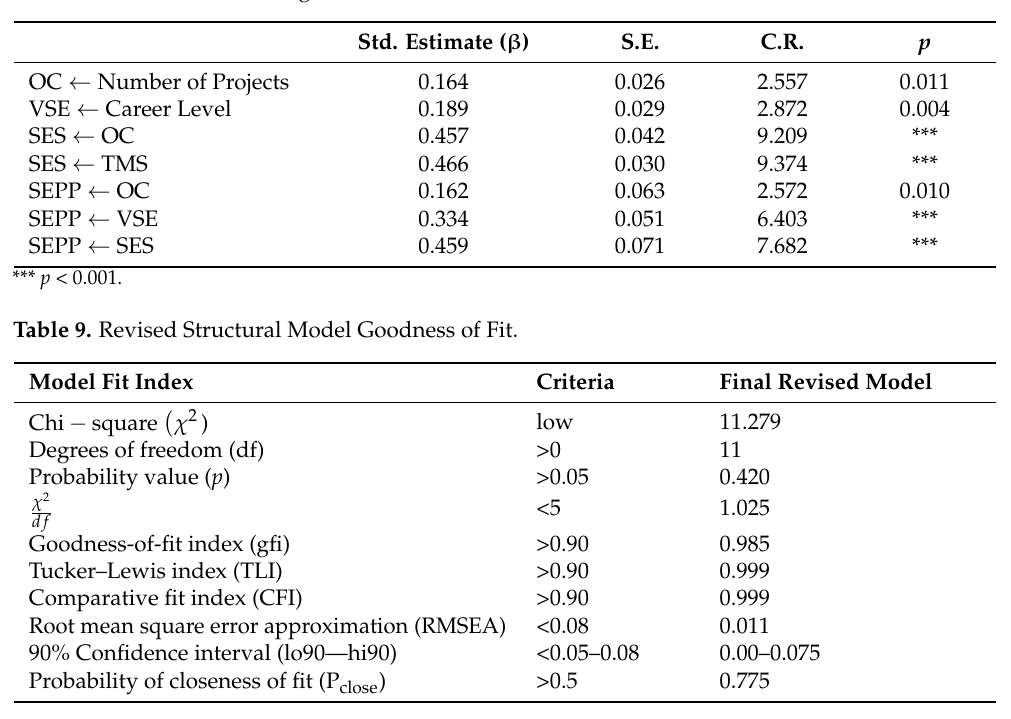
Table 8. Structural Model Regression Estimates.